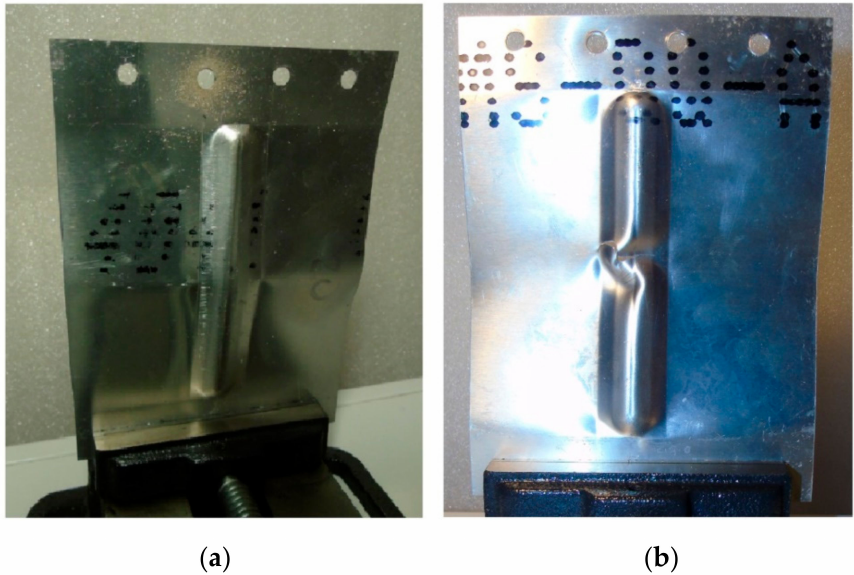
Figure 10. Buckling mode of 0.4-mm-thick EN AW-2024-T3 Alclad panel: ( a ) Mode A—the panels buckled halfway up the panel width towards the rib, without any appreciable loss of rib stability; ( b ) Model B—the rib first lost stability at half height, which was associated with breakage of the rib, and then the panel was deflected in the opposite direction to the position of the rib.